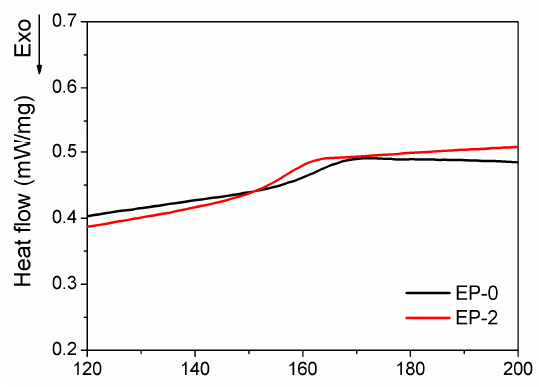
Figure 3. Differential scanning calorimeter (DSC) thermograms of the cured epoxy.